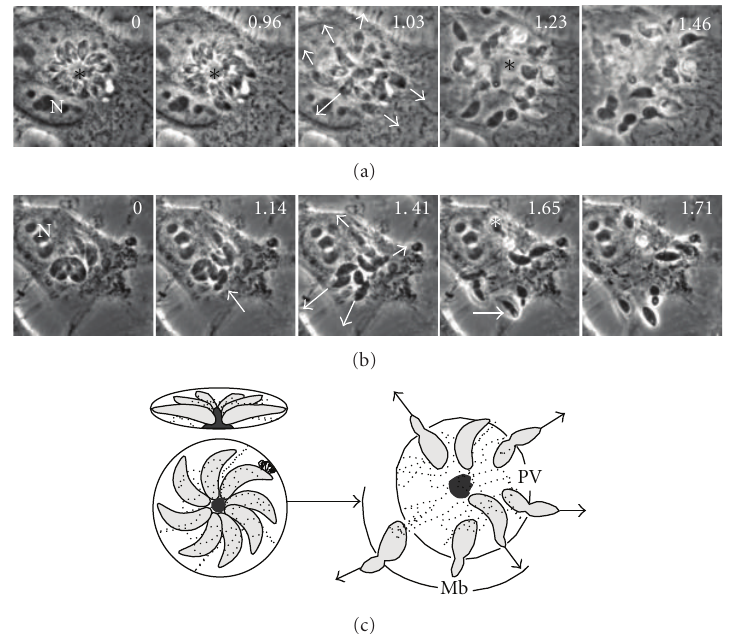
Figure 8: During exteriorization of tachyzoites, the residual body remains inside the PV. (a) Egress of RH tachyzoites arranged as “rosettes” from infected MDCK cells was induced by 0.1 µ m ionomycin and recorded by time lapse videomicroscopy. Externalizing parasites are indicated by the arrows. Arrowheads show the constriction of the tachyzoites passing through the host plasma membrane. The asterisk indicates remnants of the RB after the egress of parasites from a rosette. (b) The exteriorization of tachyzoites of Δ GRA2 strain was slightly slower than the RH strain. Several Δ GRA2 tachyzoites remained trapped in the cytoplasm or the nucleus (asterisks). Numbers in the upper right corners indicate the timing in seconds. N: nucleus of the host cell. Bars = 5 µ m. (c) represents the individual exteriorization routes followed by tachyzoites organized in